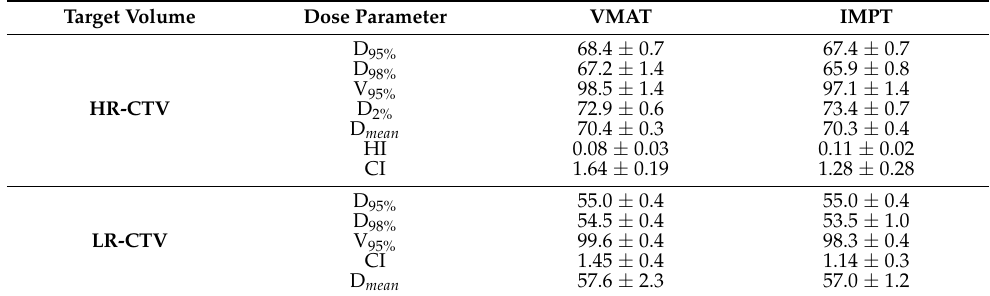
Table 3. Dosimetric comparison for target coverage between VMAT plans and IMPT plans. Data are expressed as mean values ± one standard